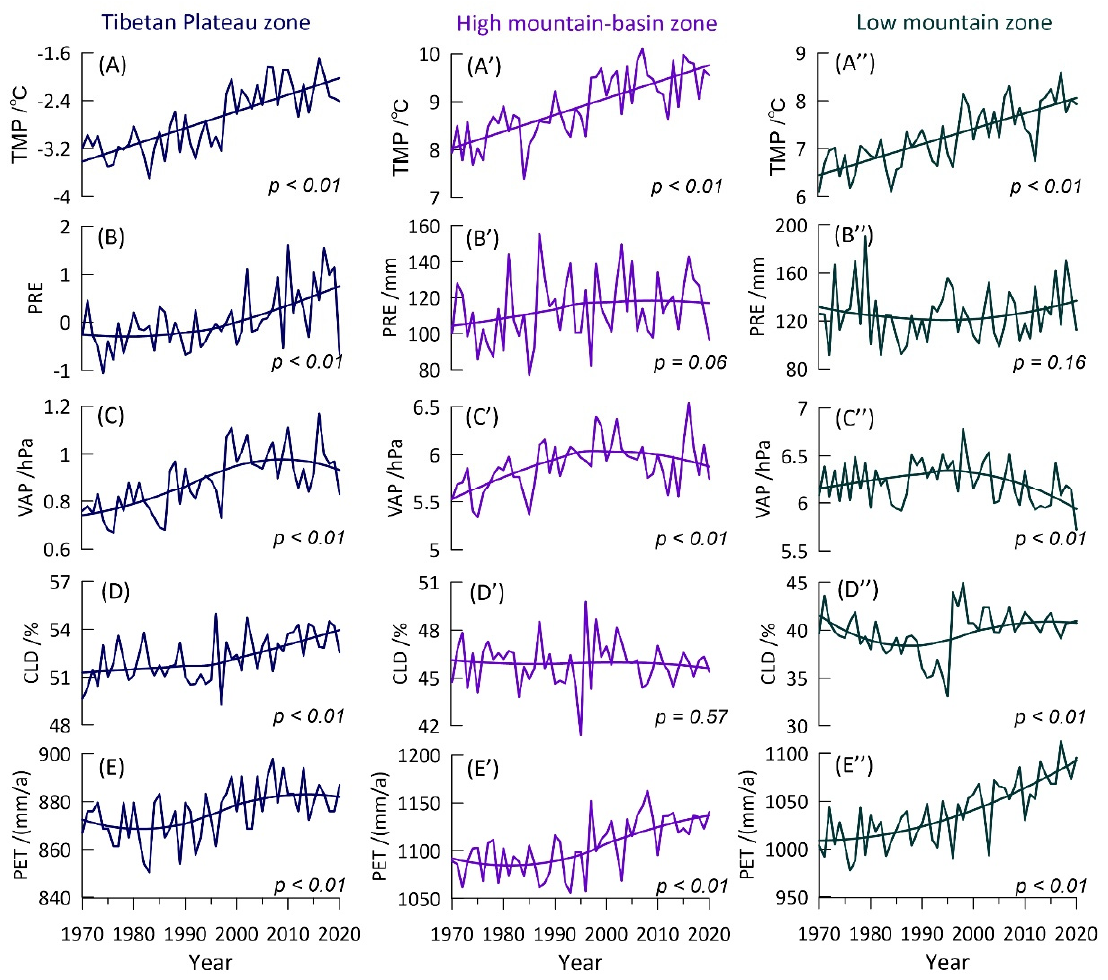
Figure 4. Evolution of different climate variables during the period 1970 ‒ 2020 in CEA. ( A – E ) represent changes in TMP, PRE, VAP, CLD, and PET, respectively, in the Tibetan Plateau zone; ( A’ – E’ ) and ( A’’ – E’’ ) are similar but for the high mountain–basin and low mountain zones, respectively. The time series (line) of TMP is a linear fit, while the other variables are smoothed by LOWESS (locally weighted scatterplot smoothing) with a span width of one year. The p -values are statistically significant trends at the 95% confidence level.